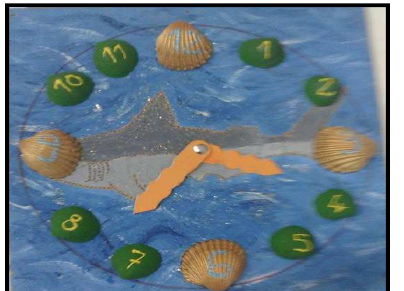
Fig. 5. Une montre réalisée par un apprenant.